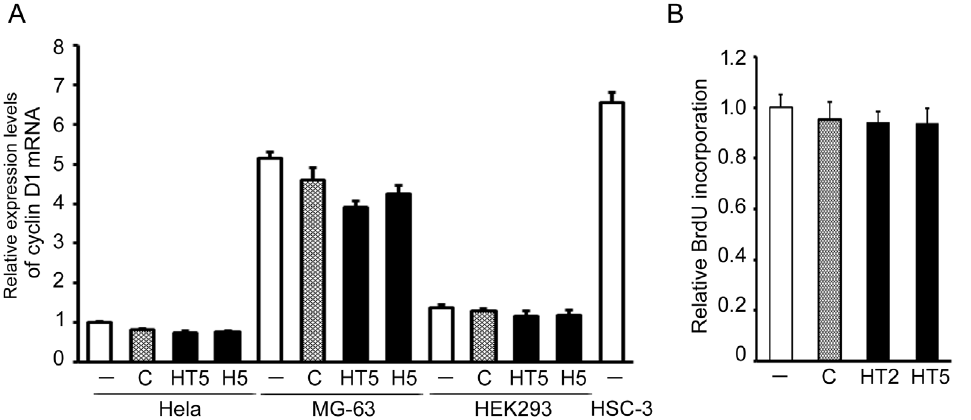
Figure 5. The effects of sgRNA targeting of cyclin D1 on cyclin D1 expression and cell proliferation of other human cancer cell lines and normal cells. (A) Hela, MG-63, HEK293 and HSC-3 cells were plated at 1 6 10 5 cells/well in 24 well dishes, and cultured for 24 h. sgHT5, sgH5, H5470 (control, C) or vehicle (-) was added at 200 nM and then the cells cultured for another 24 h. Cyclin D1 mRNA level was determined by qRT-PCR. (B) Cell proliferation of HEK293 cells was measured by BrdU incorporation using an ELISA kit. The cyclin D1 mRNA level and BrdU incorporation in the absence of sgRNAs are adjusted to 1. Each assay represents a separate experiment performed in triplicate. Data are means ¡